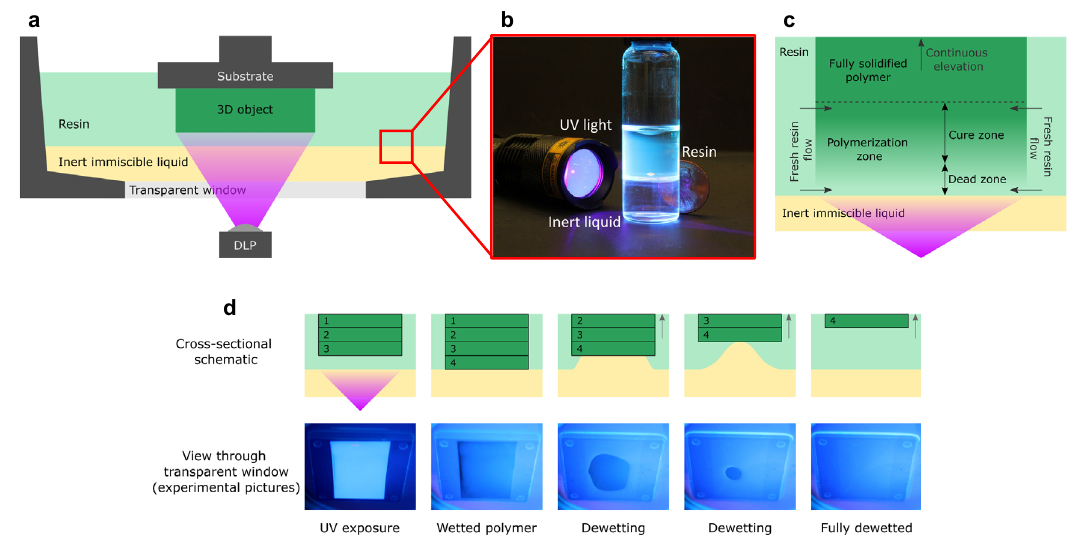
Fig. 1 Stereolithography using a static liquid constrained interface. a Schematic of an SLA system that contains an inert immiscible liquid below the photopolymerizable resin as the constraining interface. Spatially selective polymerization occurs through the projection of patterned UV light. b Vial containing two immiscible phases: top phase is a resin, and the bottom phase is an inert liquid that is transparent to UV light and has a higher density than the resin. The blue glow from the resin is caused by a fl uorescent dye in the resin. c Scheme of the continuous layerless growth process. Fresh resin fl ows into the polymerization zone comprising of a dead zone and a cure zone as the substrate is continuously elevated. The dead zone is a fi nite region of unreacted resin because of oxygen inhibition from the inert liquid. The onset of polymerization occurs within the cure zone. d Series of time-lapse schematics (cross-sectional view) and corresponding experimental observations (viewed through the transparent glass window) showing the dewetting of the inert liquid from the polymerized layer during the discrete layer-by-layer growth process (also shown in Supplementary Movie